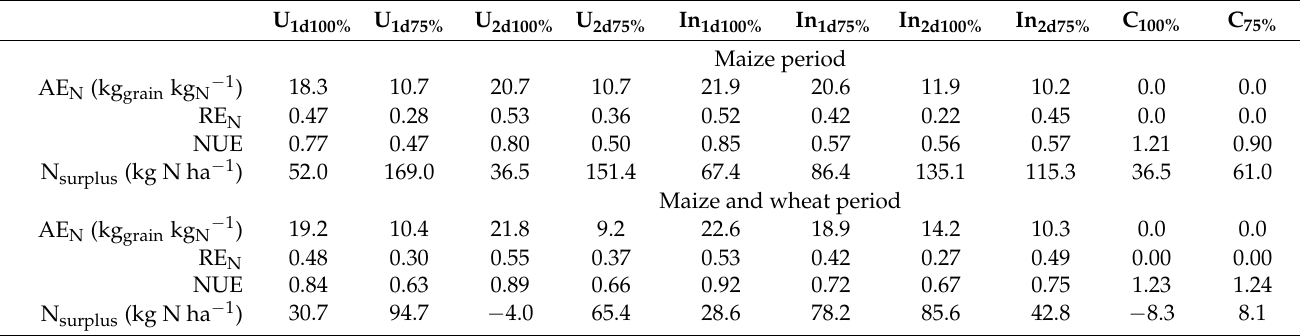
Table 4. Nitrogen efficiency parameters. Treatments were a combination of urease inhibitor use (In), simple urea use (U), or no fertilizer (C), with fertilizer application in one (1 d) or two (2 d) dressings and optimally irrigated (100%) or sub-optimally irrigated